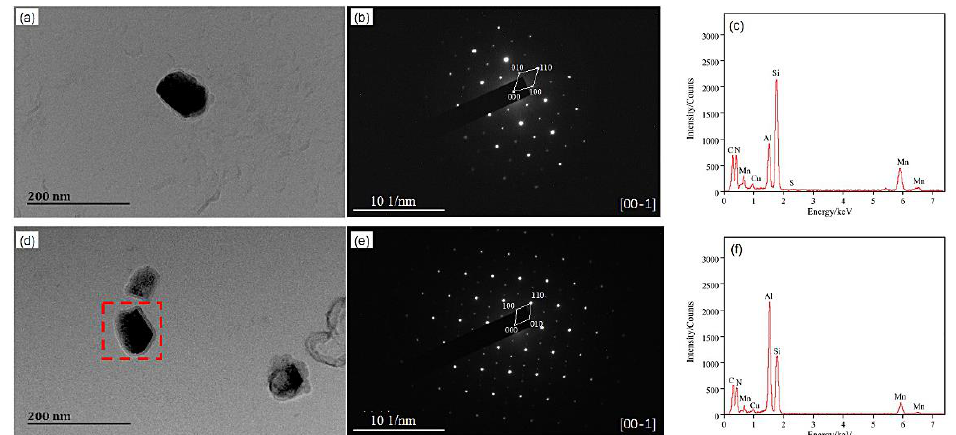
Figure 4. The morphologies, electron diffraction patterns and EDS spectra of precipitates in S2 steel extracted at 980 °C ( a – c ) and 1020 °C ( d – f ).